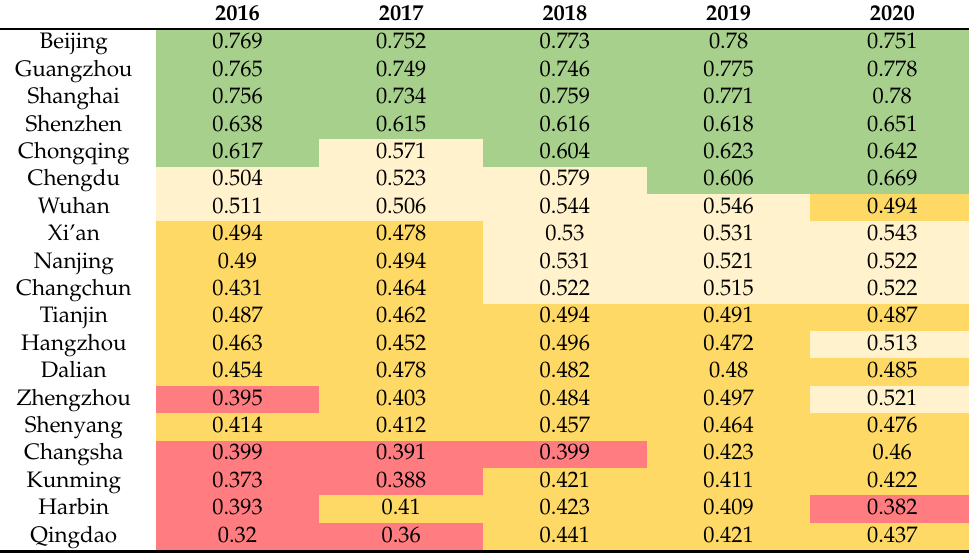
Table A3. Coupling coordination degree among B-R in 36 cities in China. Note: “-” represents no final data result for the corresponding cities.